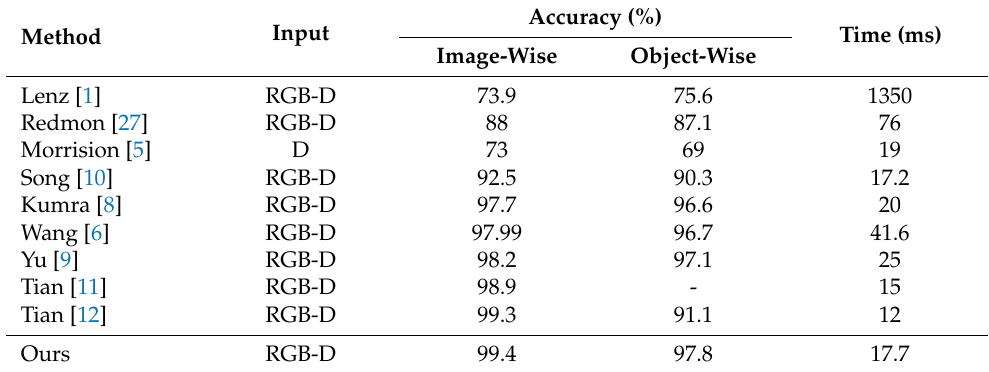
Table 2. Grasp detection results of different algorithms on Cornell